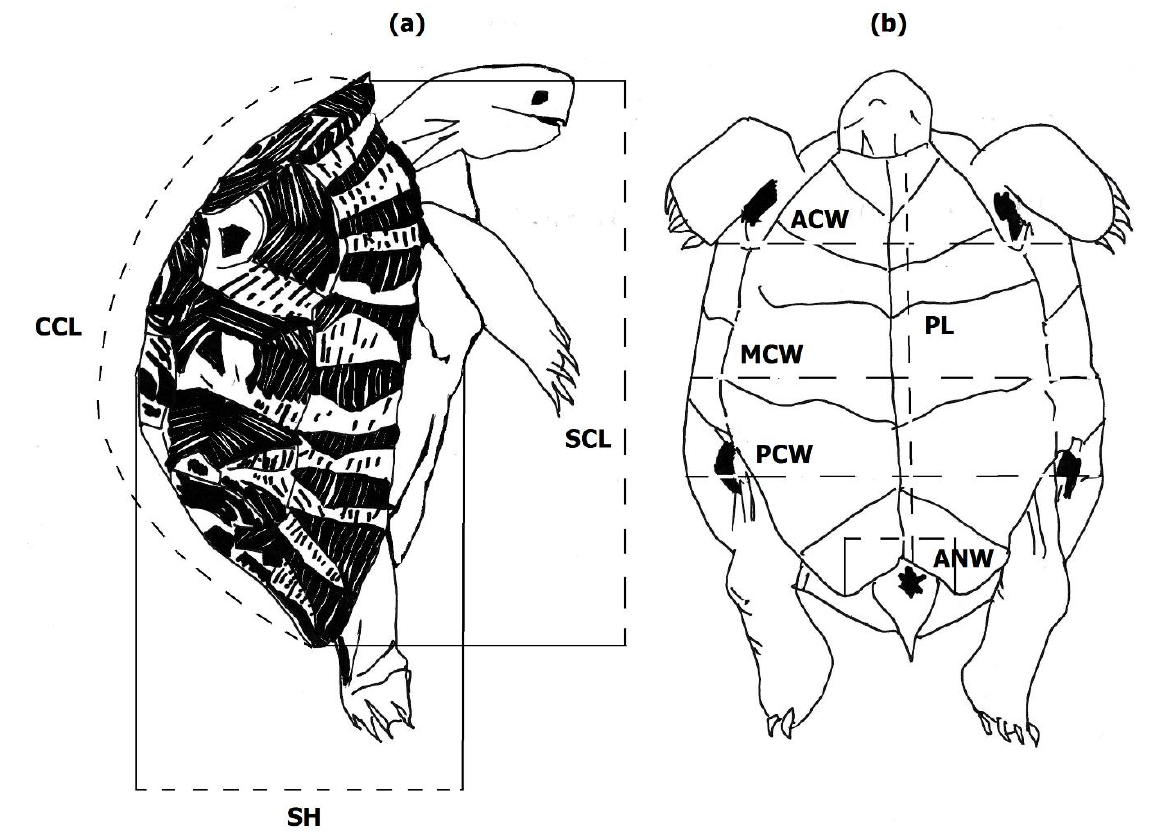
Figure 2. Selected body size descriptors: ( a ) lateral view; ( b ) ventral view. Straight carapace length (SCL; the straight anteroposterior distance between the nuchal and supracaudal scutes); curved carapace length (CCL; the midline distance along the curved carapace from the nuchal to the tip of the supracaudal scutes); mid-body carapace width (MCW; body width in the middle of the abdominal Scheme 7. th marginal scute); anterior carapace width (ACW; shell width at the junction of the gular and humeral scutes in the midline); posterior carapace width (PCW; shell width at the junction of the femoral and anal scutes in the midline-usually the maximum width); midline plastron length (PL; the straight anteroposterior distance from the front of the gular scutes to the back of the anal scute); shell height (SH; the maximum vertical measure from the top of carapace to plastron); and anal notch width (ANW; the width between the tips of the 2 anal